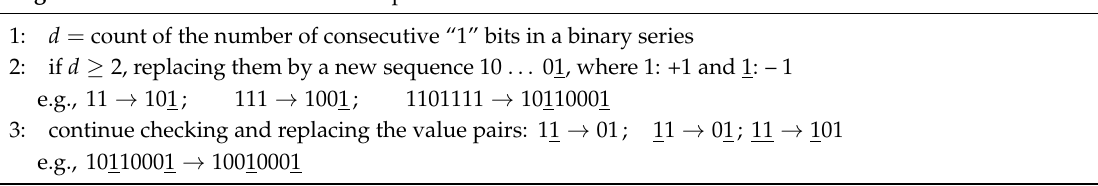
Algorithm 2 The CSD for a constant representation